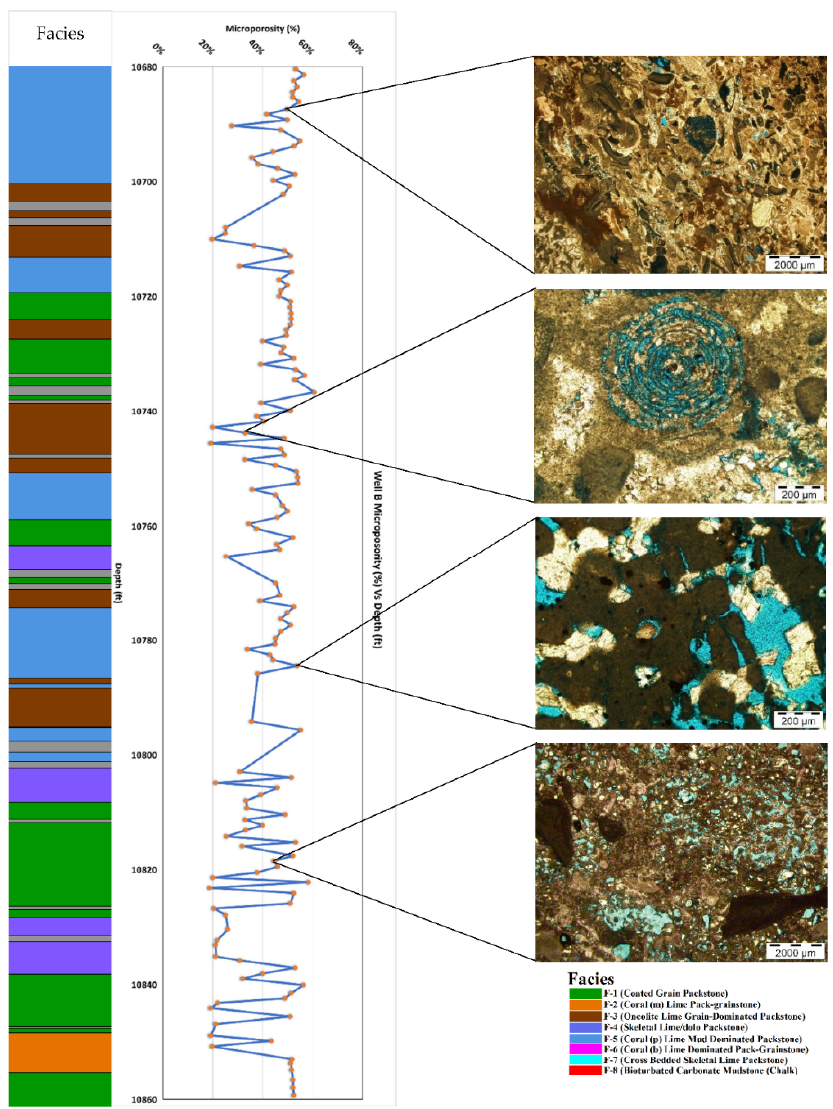
Figure 11. Macroporosity observation under transmitted light microscopy and distribution of microporosity at different depths of reservoir interval of Well A, Central Luconia, offshore, Sarawak, Malaysia.